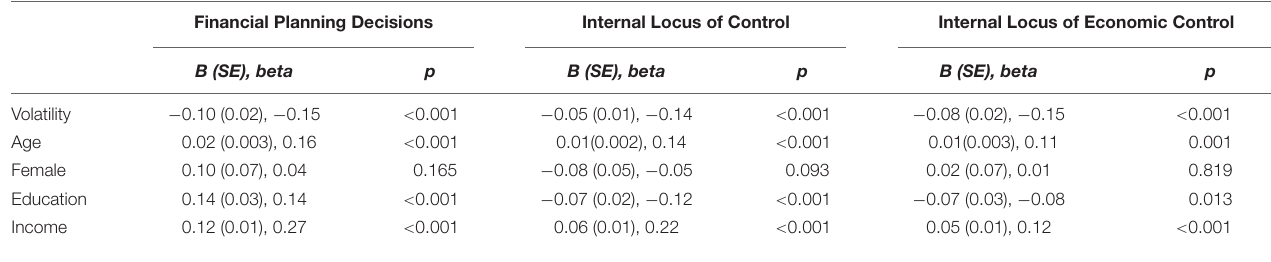
TABLE 2 | Regression estimates for the link of income volatility with the combined financial planning decisions, internal Locus of Control, internal Locus of Economic Control, controlling demographic